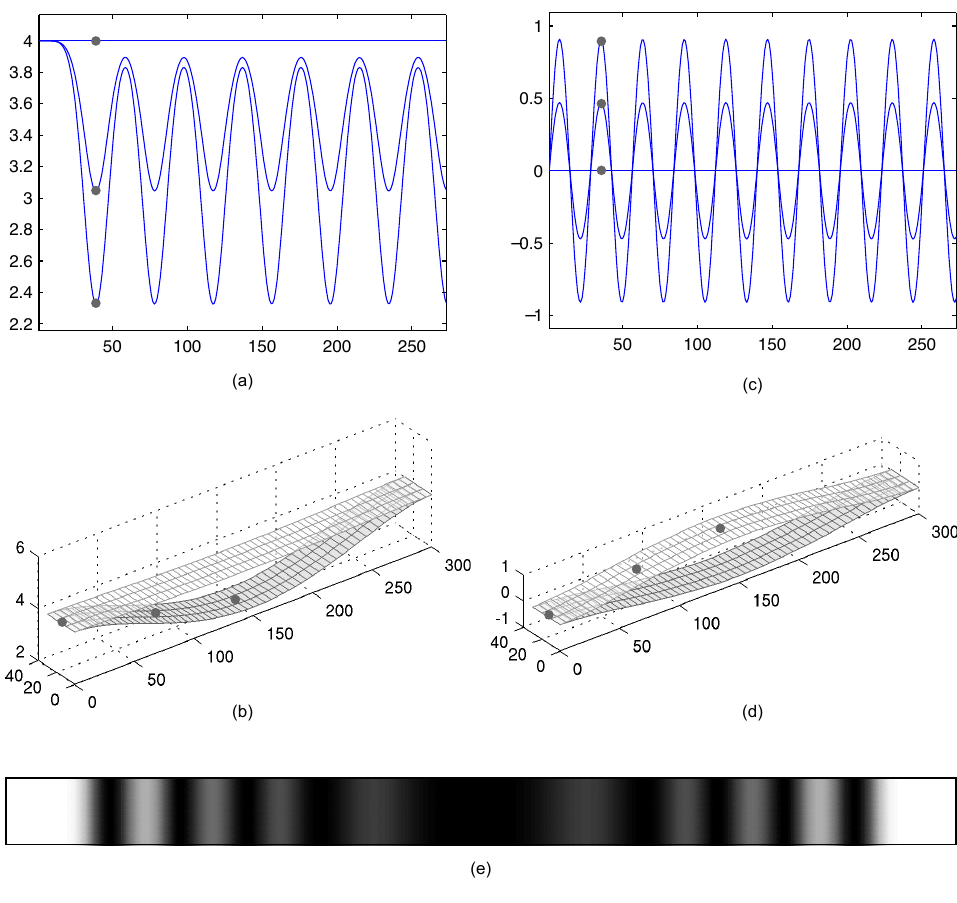
Figure 8. The formation of interference fringes for periodic and harmonic oscillation laws. Time graphs of three different points on the surface of the beam are shown in ( a ) for periodic and ( c ) harmonic oscillations. Maximum deformations of the FEM mesh are shown in (b) and ( d ). Time-averaged hologram of harmonic oscillation is given in ( e